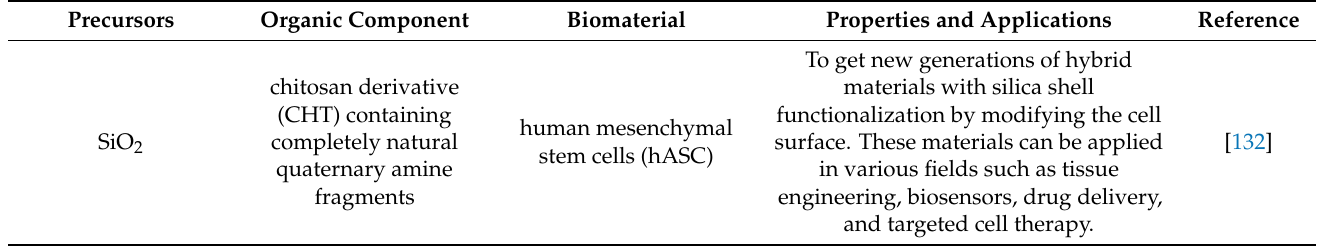
Table 1. Composition, properties, and applications of biohybrid materials obtained by the sol-gel